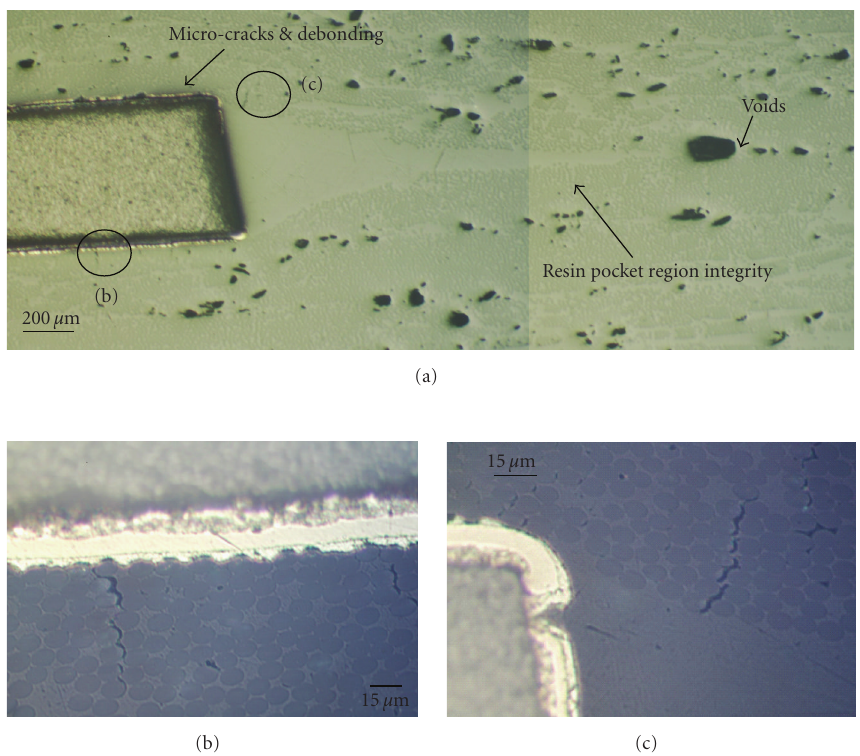
Figure 14: Sample cross-section and amplified views of debonding and microcracks around the integrated device after 100 MPa were applied on the